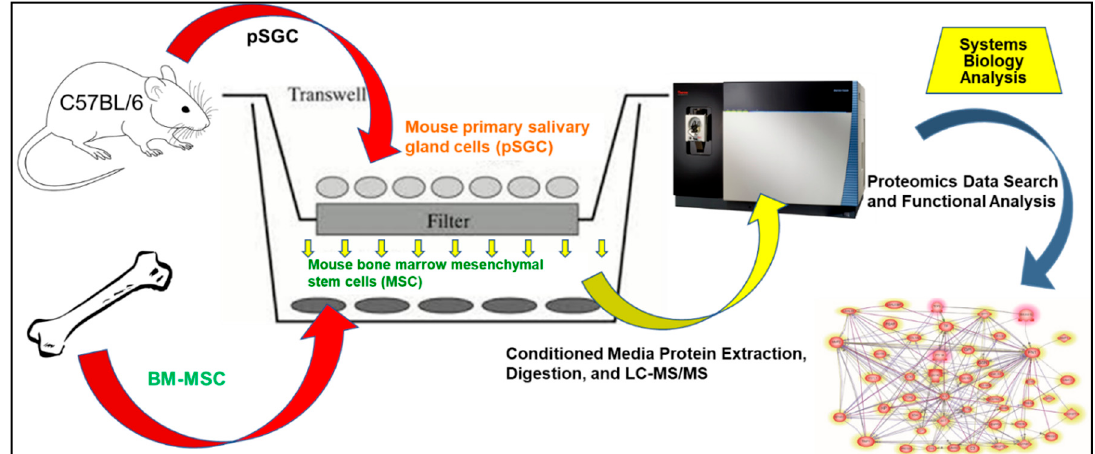
Figure 1. Experimental workflow. The workflow summarizes the various steps involved in our approach. (1) Primary salivary gland cell (pSGC) isolation from 4 week old male C57BL/6 mice; (2) co-culture of mouse bone marrow-derived mesenchymal stem cells (mMSC) and pSGC for 1, 3, 5, and